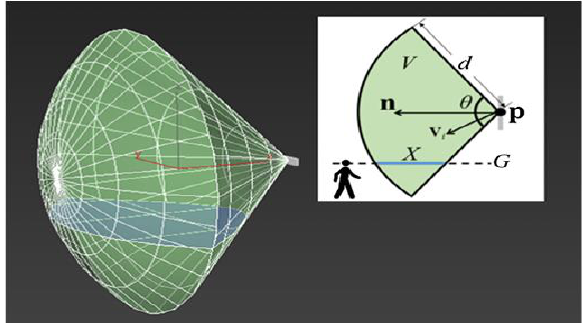
Figure 3. Visibility algorithm in Unity Representation (Motamedi et al.,